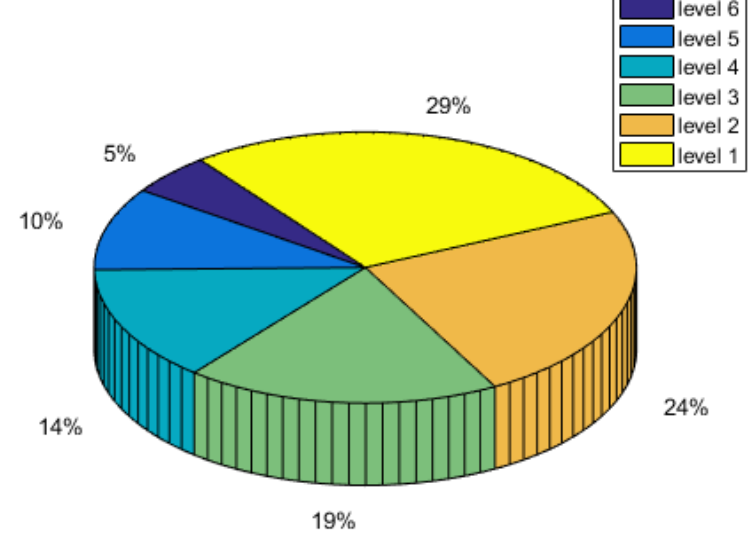
Figure 3. Roulette probability